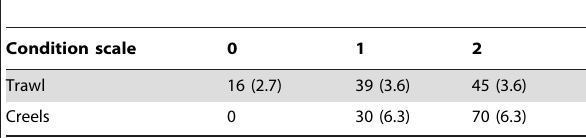
Table 4. Condition of Nephrops at arrival on